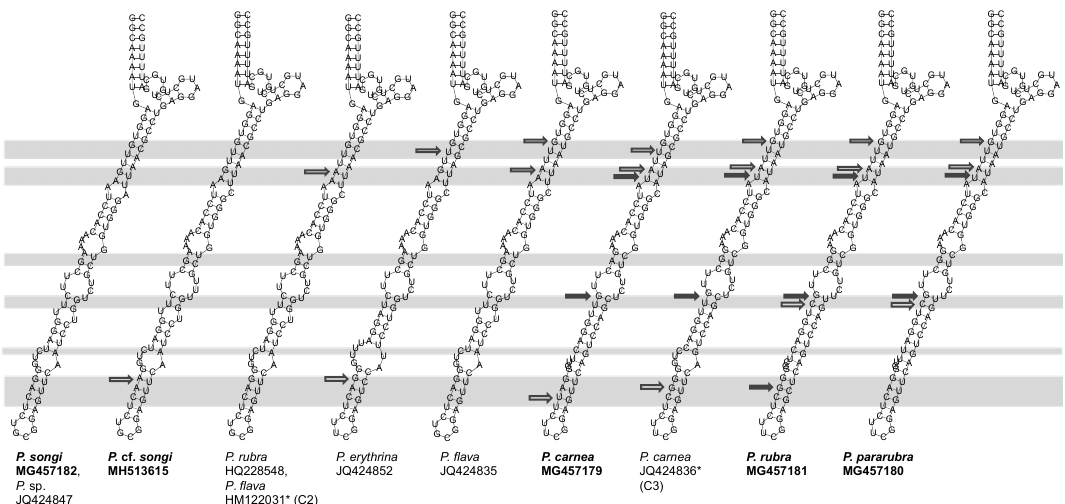
Figure 6. Helix III secondary structures of the Pseudokeronopsis LSU-D2 molecule. Using the structure of P. songi as a reference, CBCs are marked with filled arrows and hemi-CBCs are indicated with hollow arrows. The variable regions are marked by grey boxes. Newly sequenced species are in bold. *, misidentified species. Table 4. Compensating base changes of LSU-D2 between Pseudokeronopsis species / Table 3. Compensating base changes of ITS2 between Pseudokeronopsis species/populations. Species/Populations